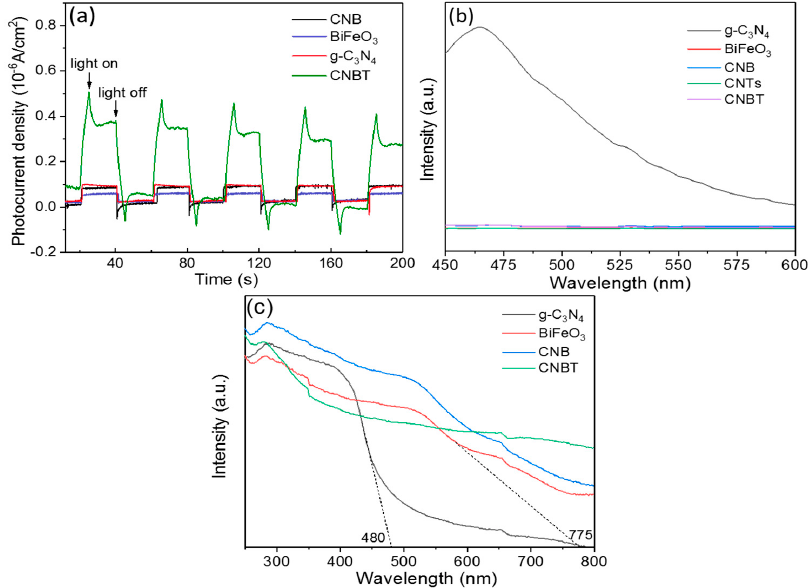
Figure 7. ( a ) Photocurrent response density. ( b ) Photoluminescence spectra. ( c ) UV-Vis spectra.